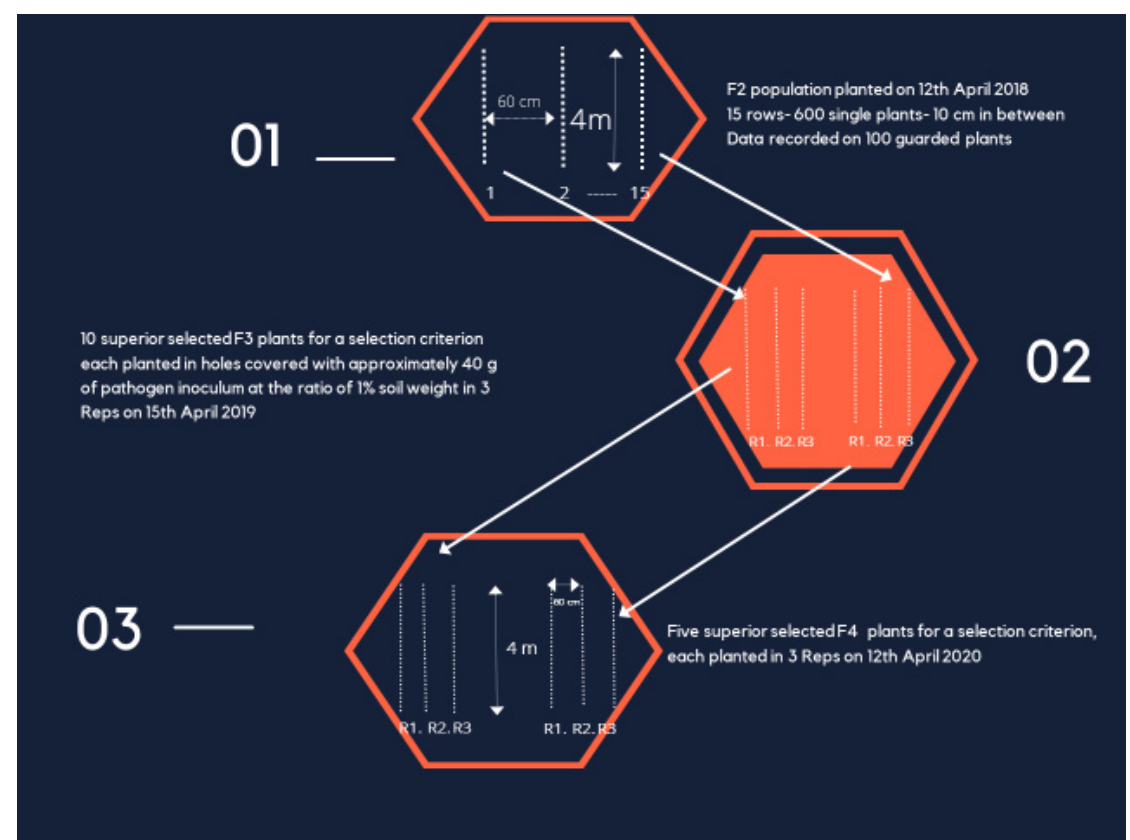
Figure 1. Demonstration of the two cycles of selection in F 2 , F 3 , and F 4 ‐ generations .